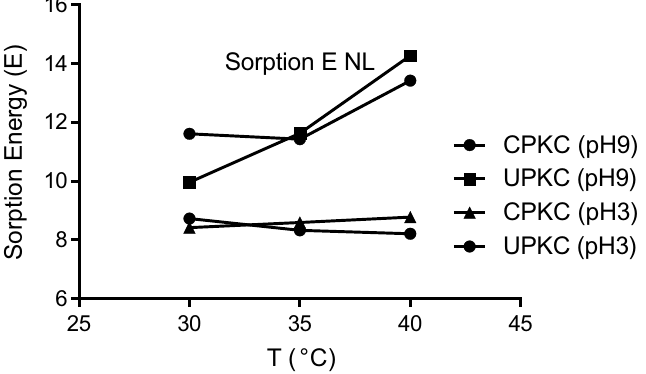
Figure 5. Sorption energy of CPKC and UPKC for different pH.